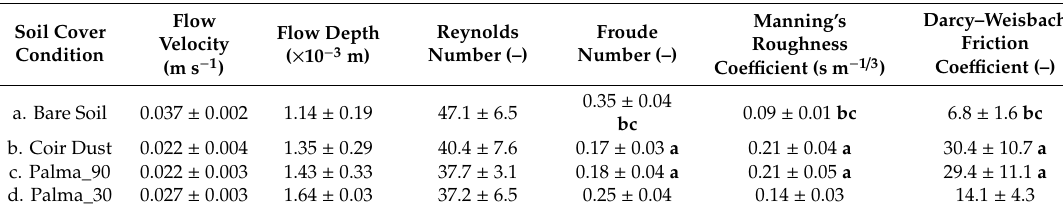
Figure 7. Bar graphs (mean and standard deviation of three repetitions) of hydraulic parameters of runoff estimated for all soil cover conditions and the uniform rainfall pattern: ( A ) Flow velocity, ( B ) flow depth, ( C ) Reynolds number, ( D ) Froude number, ( E ) Manning’s roughness coefficient and ( F ) Darcy–Weisbach friction coefficient. Table 3. Mean ± standard deviation (of three repetitions) of hydraulic parameters of runoff estimated for all soil cover conditions and the uniform rainfall pattern. Values for a soil cover condition followed by letters in bold ( p < 0.05) are statistically significantly different from the soil cover condition corresponding to that letter.